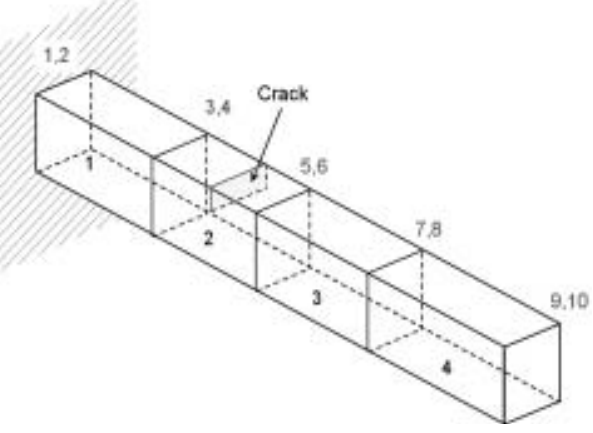
Fig. 1. Simulated Cantilever beam with Crack (a) Simulated Healthy Beam’s 8-Element Model Time Signal. (b) Simulated Damage Beam’s 8-Element Model Time Signal.